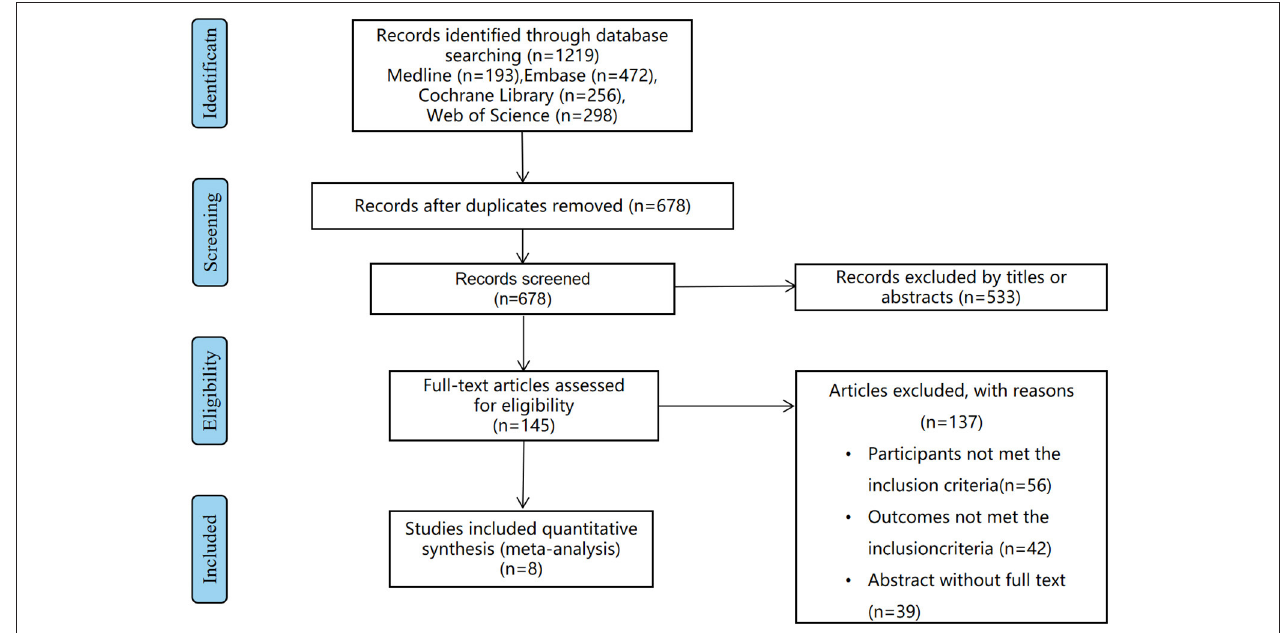
FIGURE 1 | Methodological flowchart of the